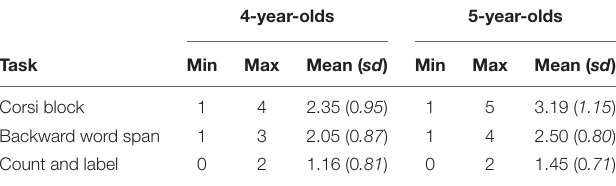
TABLE 1 | Working memory task performance by age